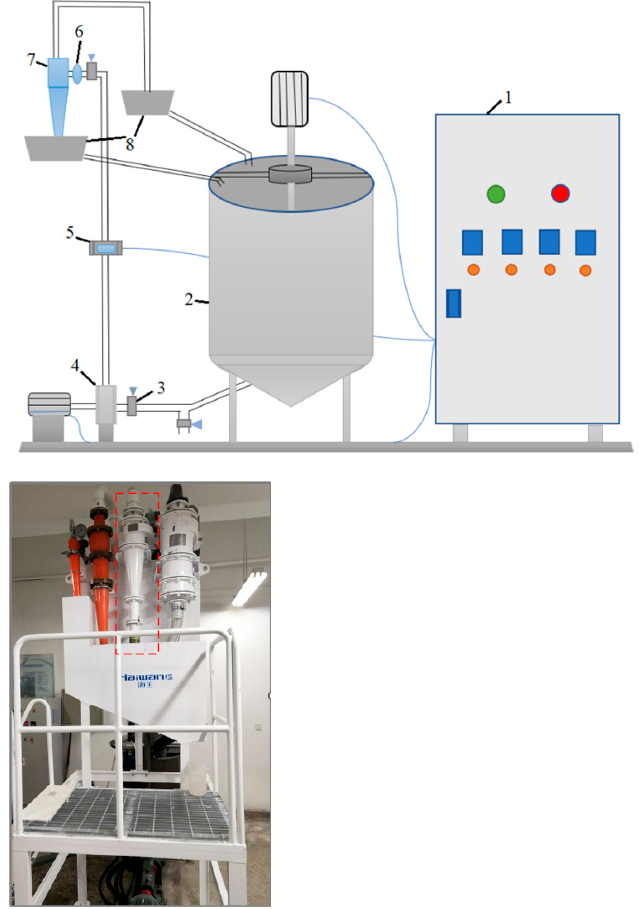
Figure 7. Schematic diagram and implementation of laboratory test rig on the Φ 150 mm hydrocy- clone. 1—Electric cabinet; 2—Mixing tank; 3—Butterfly valves; 4—Centrifugal pump; 5—Magnetic flowmeter; 6—Pressure transmitter; 7—Hydrocyclone; 8—Product sumps.